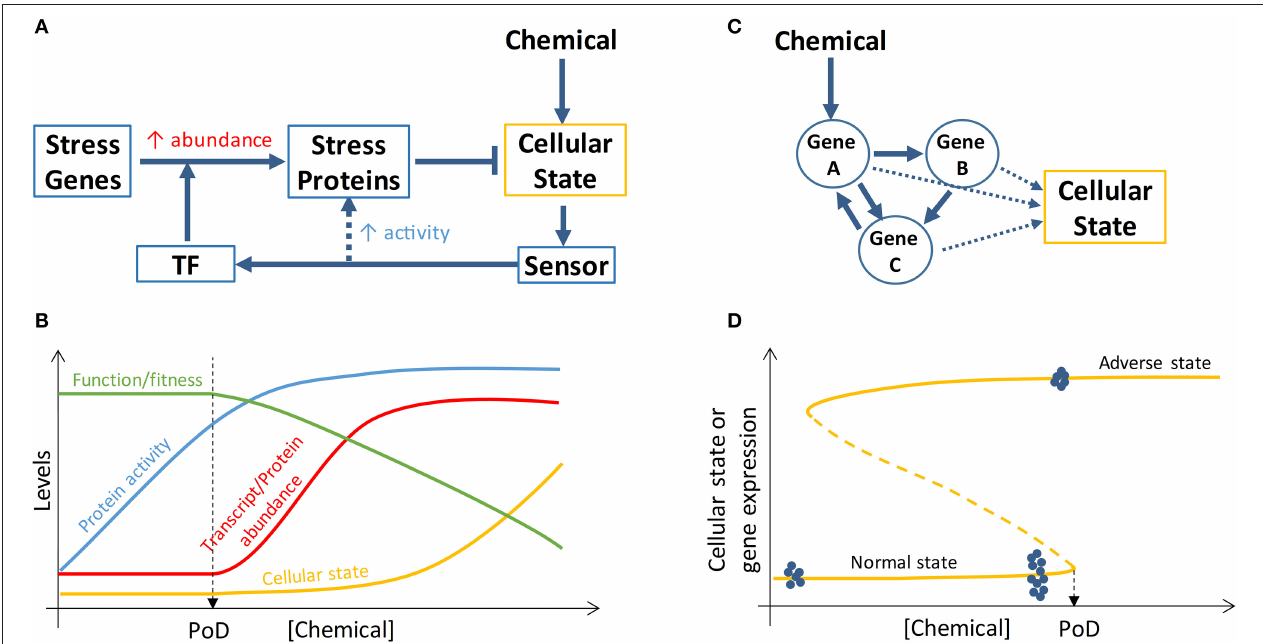
FIGURE 2 | Schematic illustration of PoD resulting from perturbation of stress pathways and bistable gene networks. (A) A simplified view of a cellular stress response network where posttranslational control (dashed arrow) increases the activities of stress proteins and transcriptional control activated by transcription factor (TF) increases the abundance of stress proteins. (B) Chemical concentration-dependent transition of the stress response. At low chemical concentrations, the activities of basal, preexisting stress proteins are augmented (through posttranslational control) to maintain homeostasis of the cellular state and specialized cell function and fitness are intact. When the chemical concentration reaches a level that maximizes the activities of the preexisting stress proteins, transcriptional control is initiated to increase the abundance of stress proteins to continue to maintain homeostasis and survival. The onset of transcriptional control may define a PoD because specialized function/fitness may be compromised due to translational and metabolic reprogramming (not shown and refer to main text for details) associated with transcriptional control. (C) Cellular phenotype can be determined by the state of a gene network which can be perturbed by chemicals. (D) If the gene network forms a bistable switch, the bifurcation point of the network defines a PoD. For chemical concentrations below the PoD concentration, cells remain in the normal state; for chemical concentrations above the PoD concentration, cells switch to the adverse state. Gene expression levels can exhibit different variabilities depending on the cellular state. When normal-state cells are exposed to chemical concentrations well below the PoD concentration, the variability of gene expression within the bistable gene network is small (blue dots on the far left of the curve, representing gene expression levels in single cells). When normal-state cells are close to the PoD, gene expression variability dramatically increases (blue dots close to PoD). Once cells switch to the adverse state, gene expression variability decreases again (blue dots on the top curve). Refer to main text for further